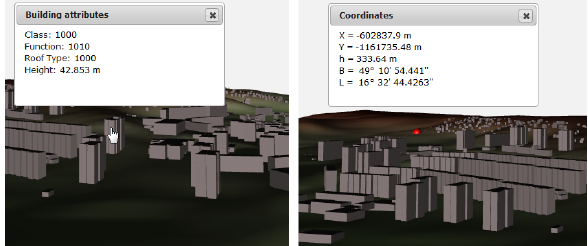
Figure 8. Popup windows – attributes of selected building (left) and coordinates upon clicking on the respective item